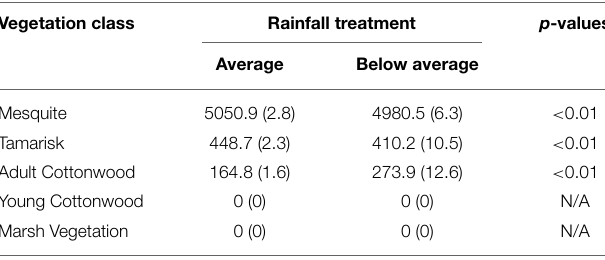
TABLE 3 | Total area (ha) of differing quality values (1-lowest, 5-greatest) for agriculture, recreation, and aesthetics ecosystem services produced in the average and below average rainfall treatment